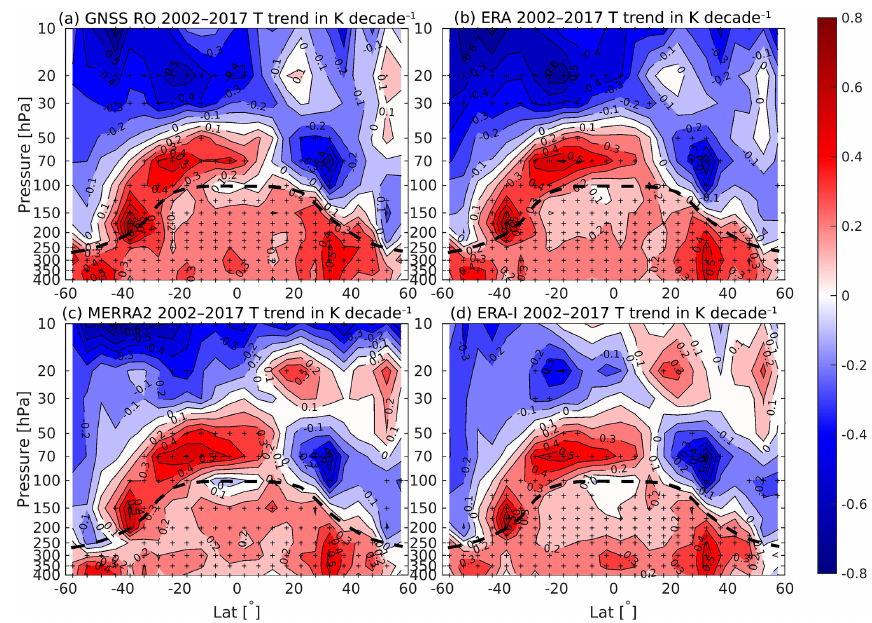
Figure 11. Temperature trend in K per decade based on GNSS RO (a) , ERA5 (b) , MERRA2 (c) and ERA-I (d) data for the period 2002–2017. The “ + ” marks the significant area at 95% level. The dashed black lines mark the tropopause height calculated with GNSS RO